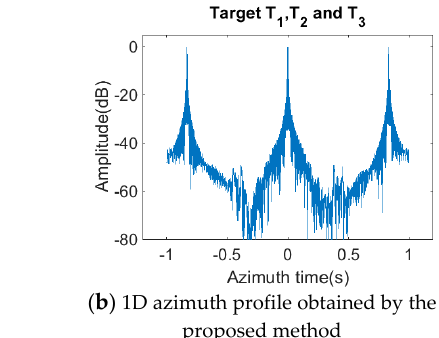
Figure 13. Focused point target results of T 7 , T 8 , and T 9 : ( a ) focused result of T 7 ; ( b ) focused result of T 8 ; and ( c ) focused result of T 9 . Figure 14. 1D Azimuth profiles of T 1 , T 2 , and T 3 : ( a ) 1D azimuth profile obtained by the adding zeros operation; and ( b ) 1D azimuth profile obtained by the proposed method.